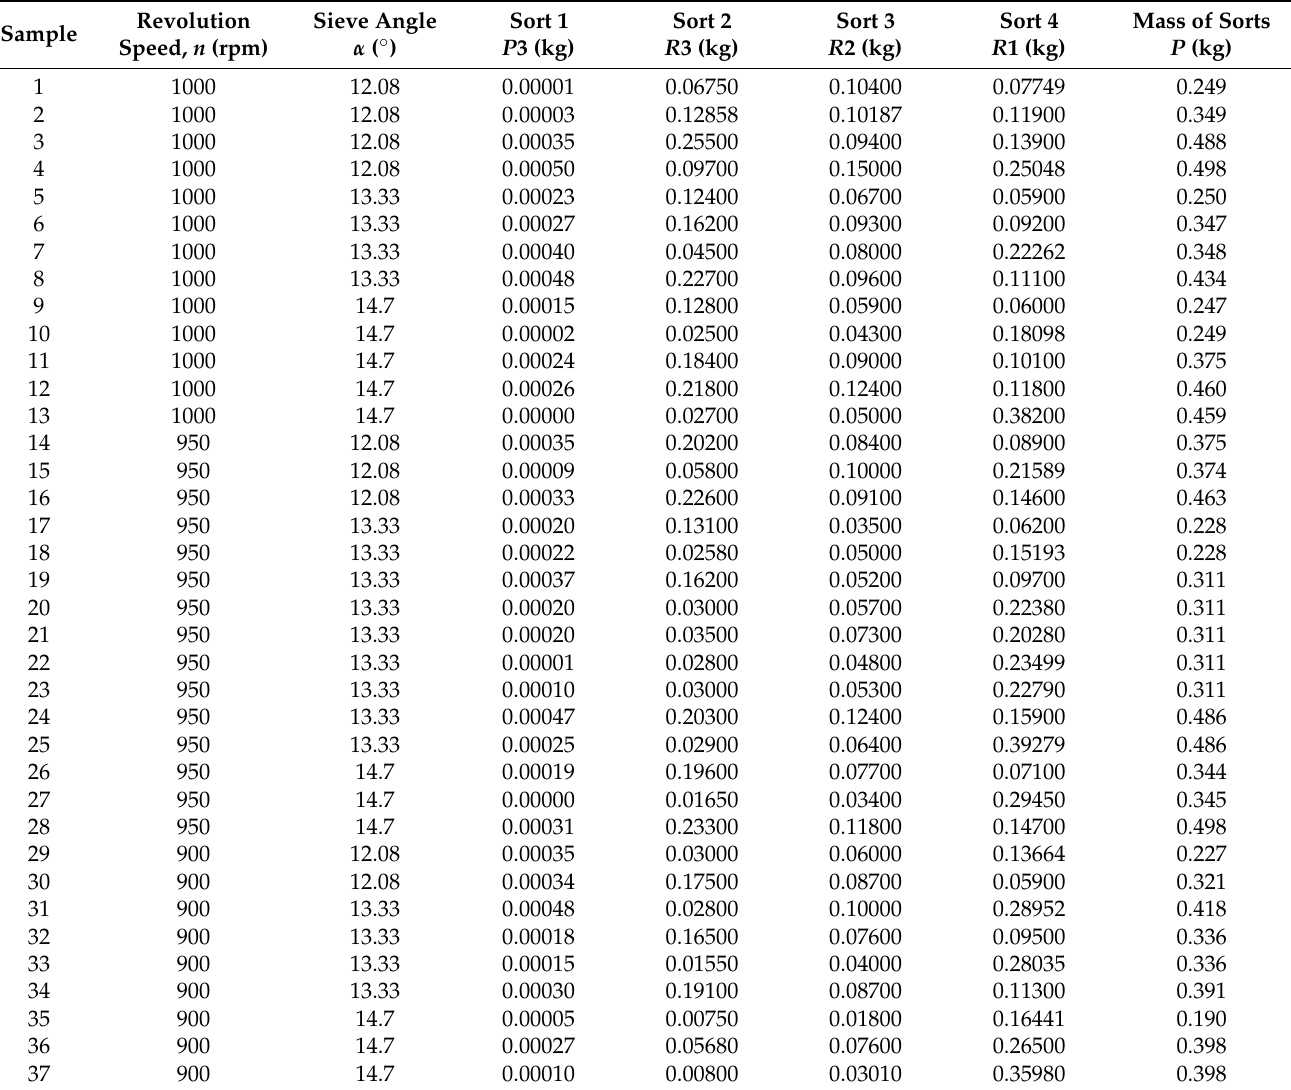
Table 3. Experimental raw data for chopped nettle